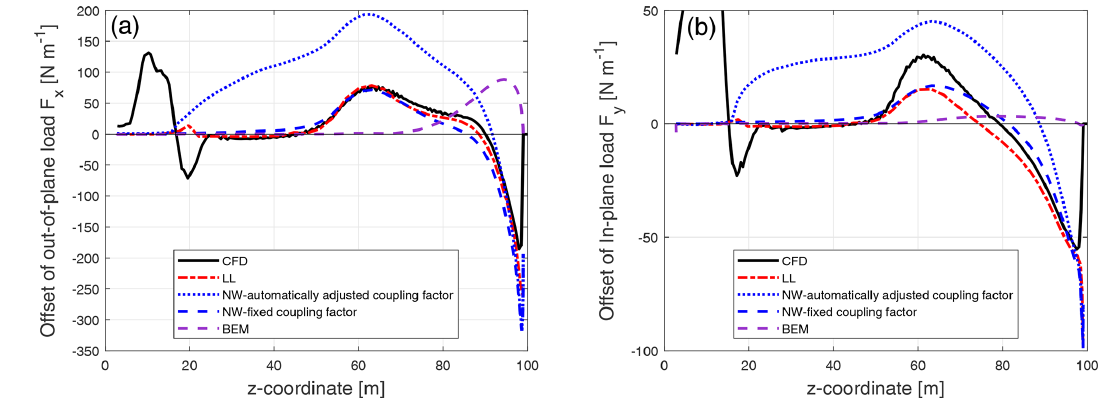
Figure 10. Comparison of the difference between the out-of-plane load (a) and the in-plane load (b) of the forward swept Blade-5 with respect to the baseline blade calculated from the Navier–Stokes solver (CFD), the lifting-line method (LL), the proposed coupled method (NW) and the blade element momentum method (BEM).